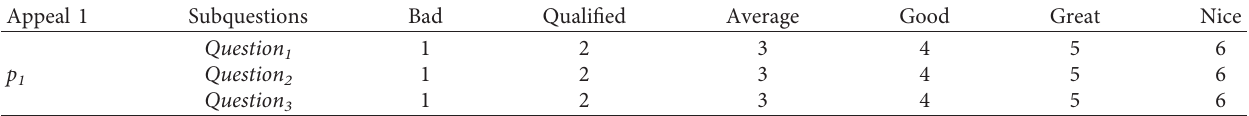
Table 1: Value of response to appeal 1 ( p